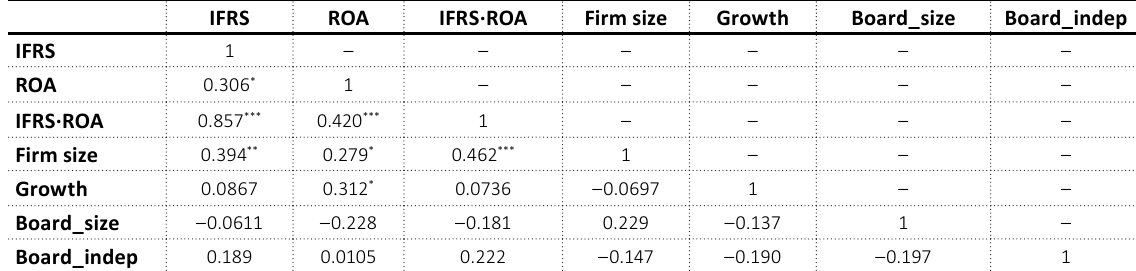
Table 3. Static panel data analyses of IFRS adoption in CEO compensation